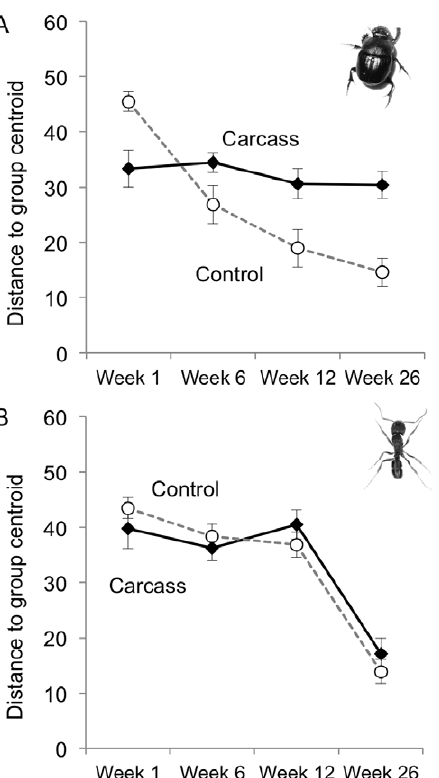
Figure 5. Effect of carrion on insect assemblage heterogeneity. Average distance to group centroid, reflecting heterogeneity in composition among samples of (a) beetles and (b) ants from carrion and control treatments. Error bars show mean 6 SE.